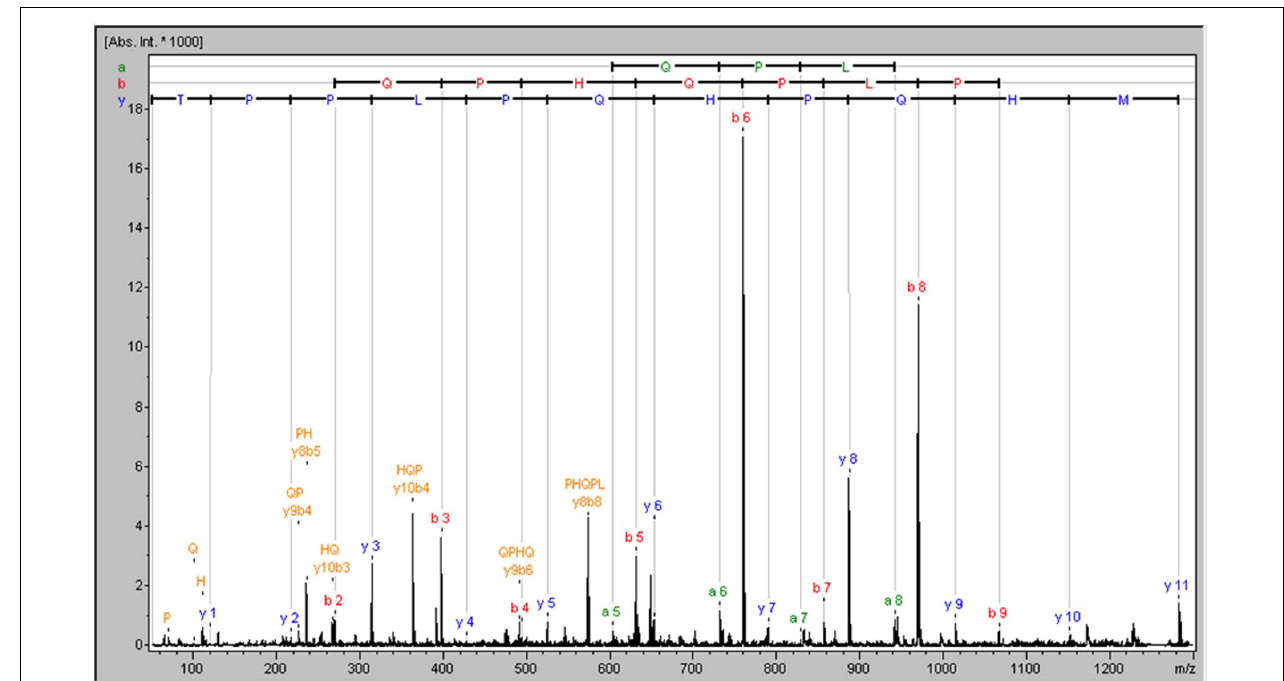
FIGURE 1 | MALDI mass spectrum of the common peptide among functional fractions obtained following purification by cationic exchange chromatography.